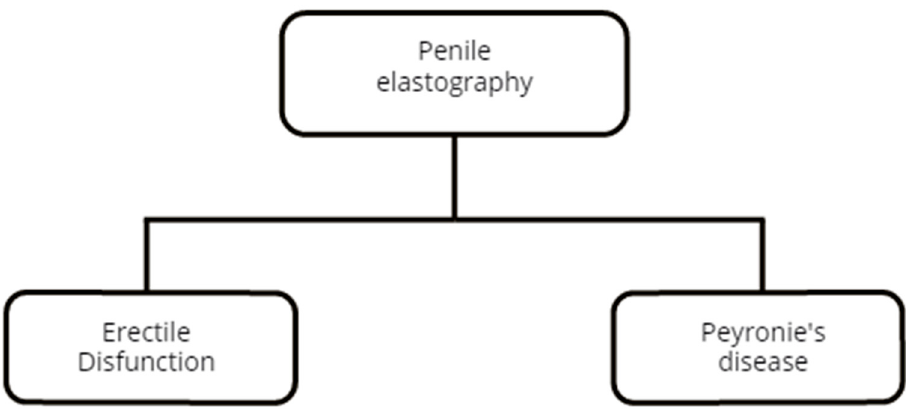
Figure 6. Penile pathologies evaluated by elastography.